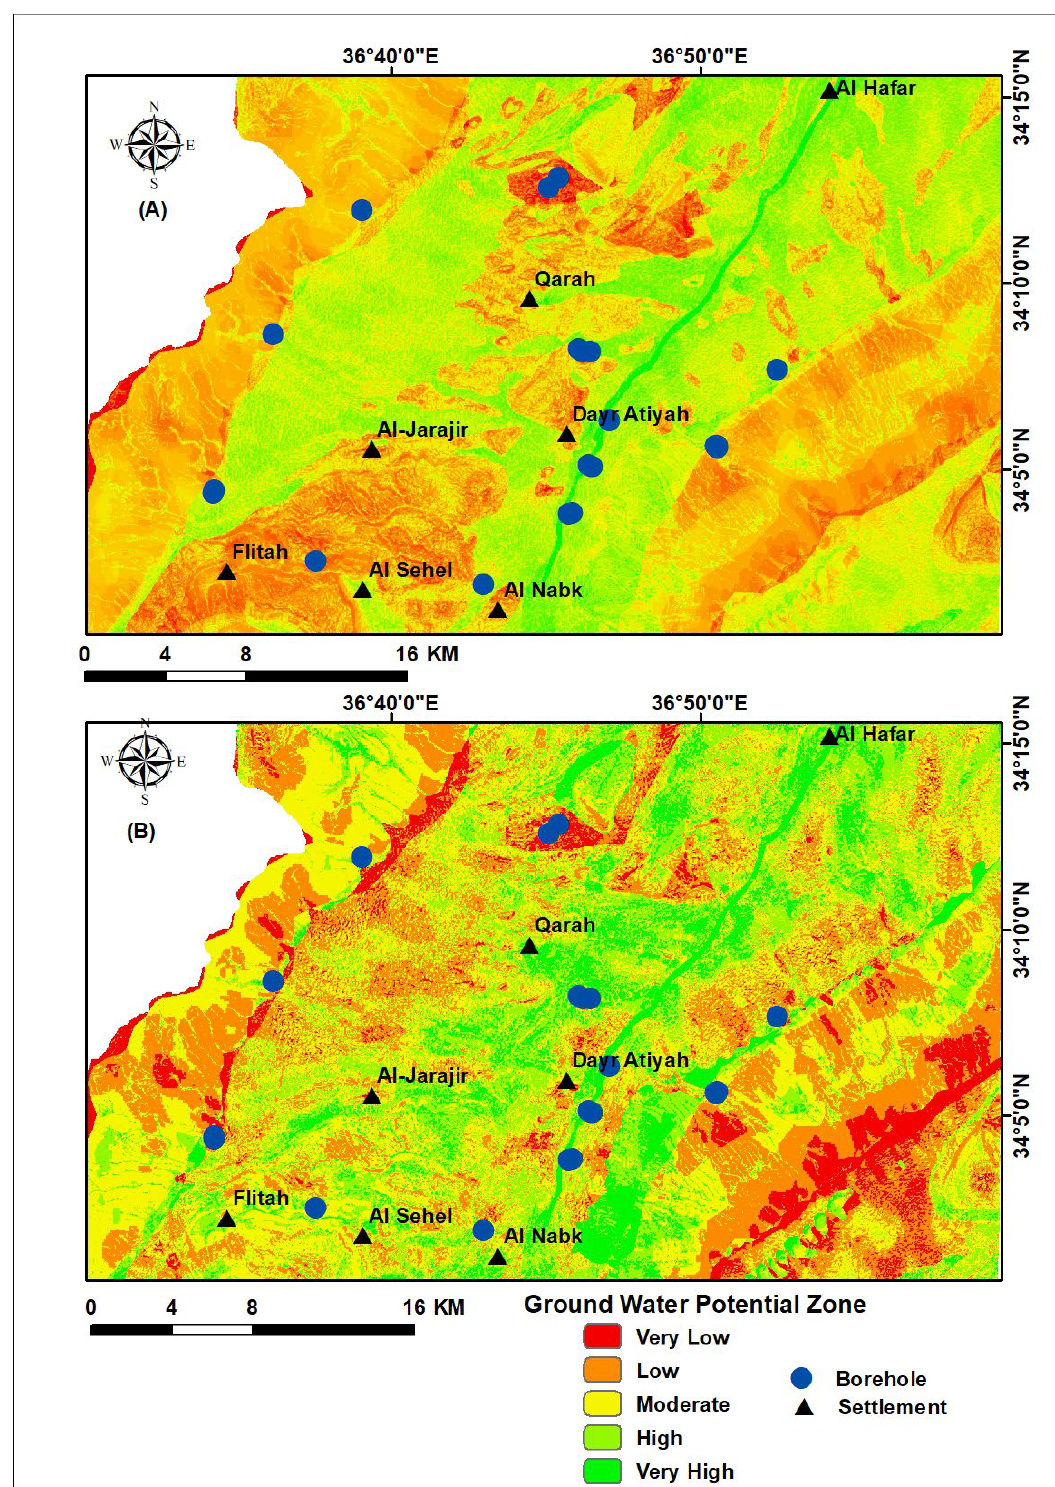
Figure A3. Groundwater Potential Zone of the ( A ) AHP3 and ( B ) MIF3 maps.